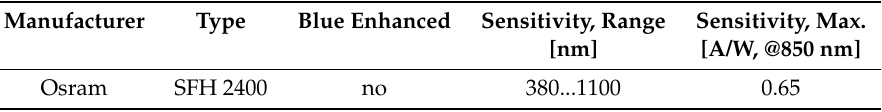
Table 2. Key parameters of Si PIN photodetector used for